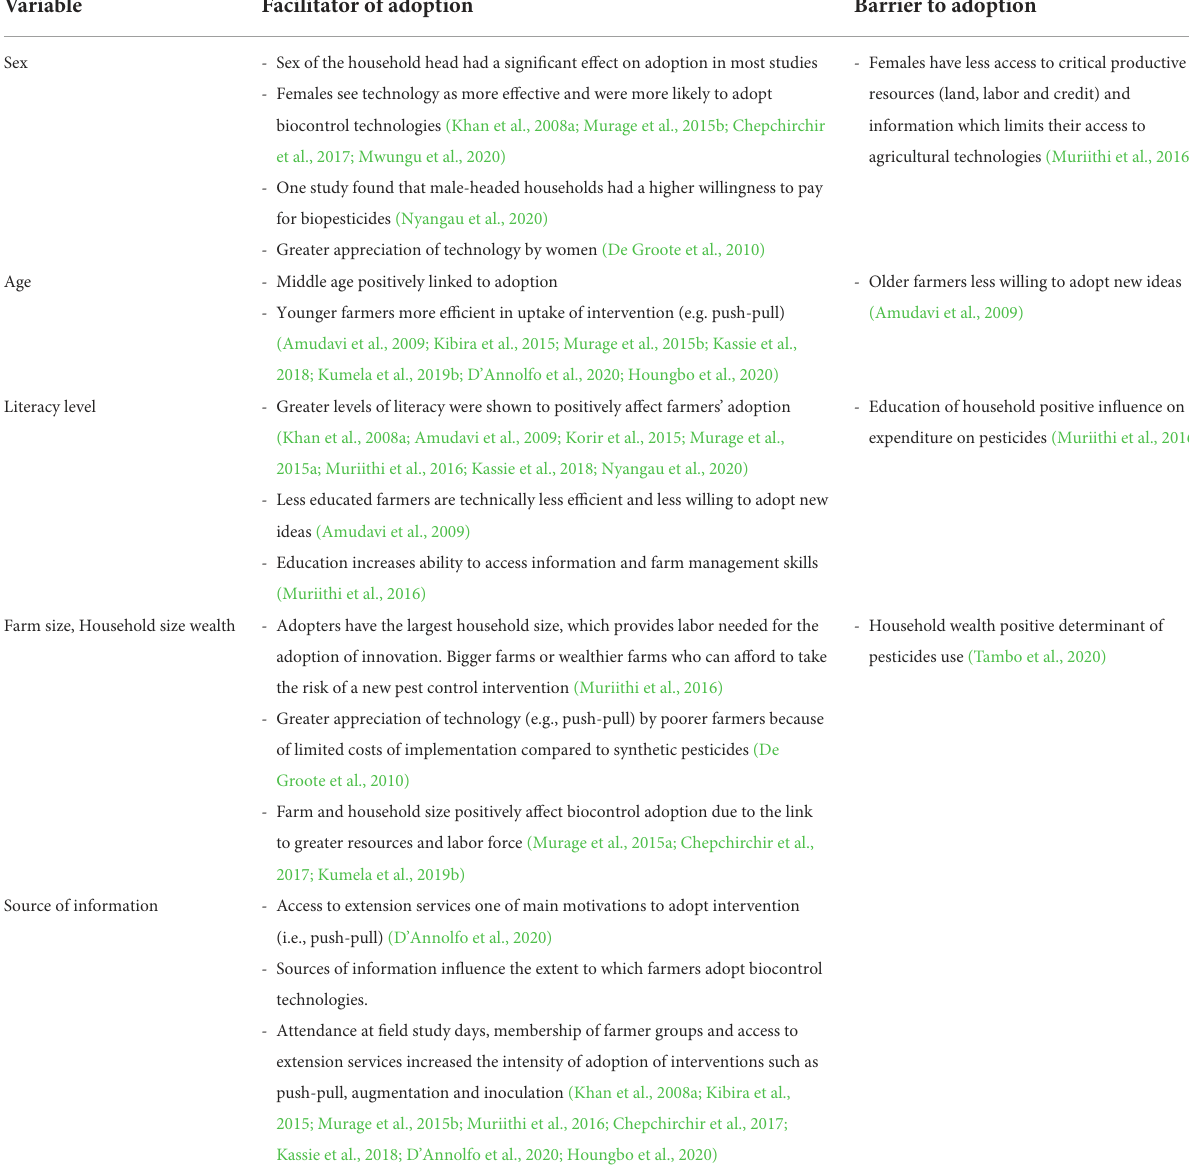
TABLE 2 Contextual factors affecting the adoption of biocontrol interventions by farmers in sub-Saharan African. Variable Facilitator of